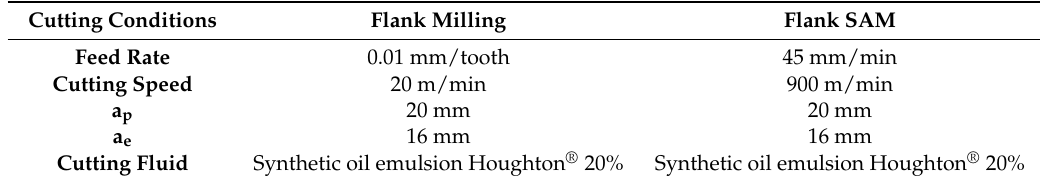
Table 2. Defined cutting conditions for the experiments.